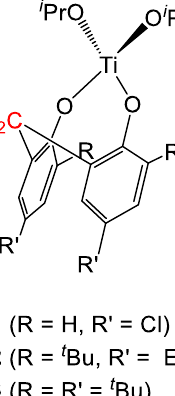
Figure 5. Titanium complexes bearing methylene-bridged diphenol and binaphthol derived ligands [10,11].